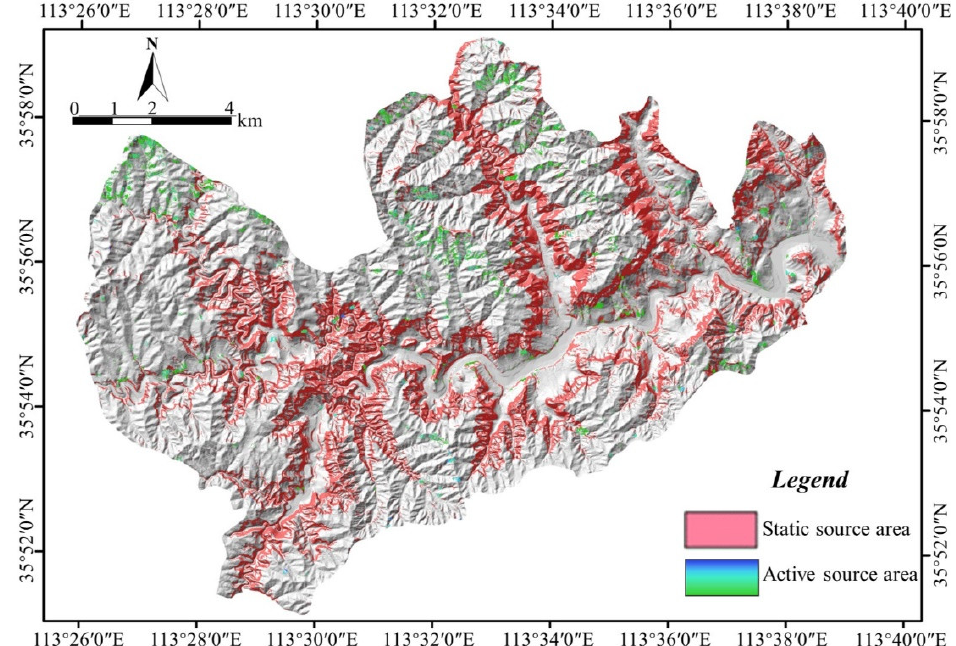
Figure 18. Distribution map of potential rockfall source areas in the Taihang GCSA.